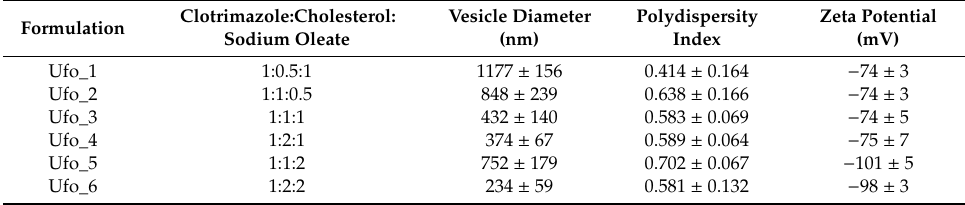
Table 1. Summary of vesicle diameter, polydispersity index and zeta potential results of ufosomes. Data are presented as mean ± SD ( n = 3).